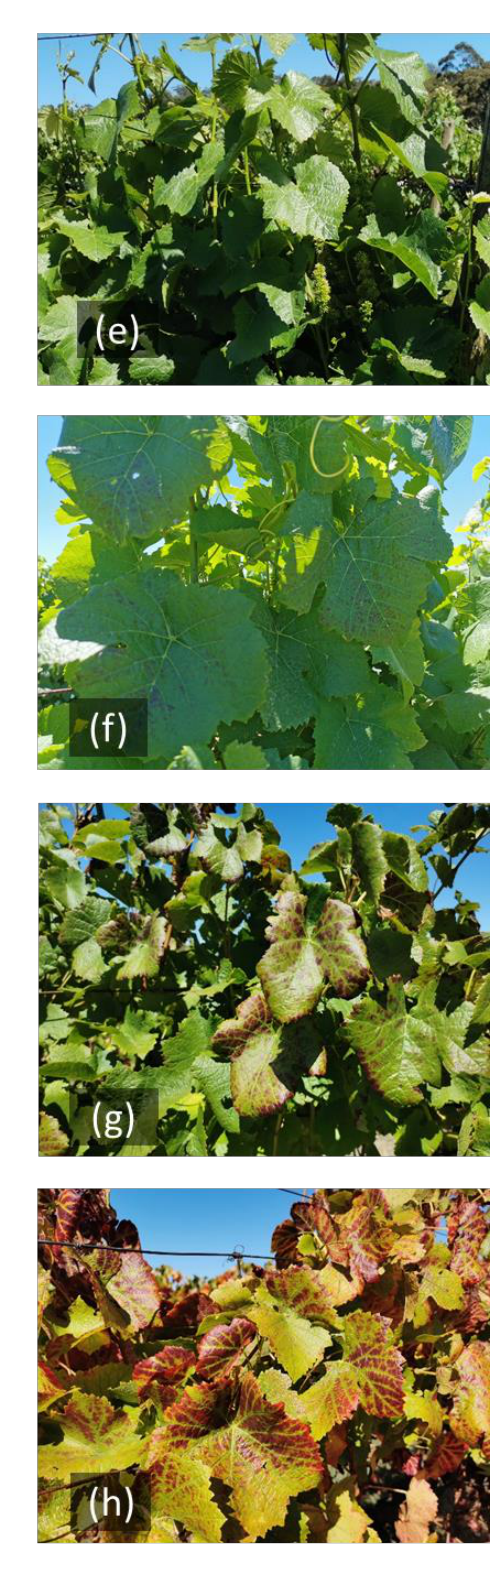
Figure 4. The GLD-infected vines at different development stages. Chardonnay in ( a ) November — flowering stage (EL-17); ( b ) December — pea-size berries; ( c ) February — veraison; ( d ) April — post- harvest. Pinot Noir in ( e ) November — flowering; ( f ) December — pea-size berries; ( g ) February — veraison; ( h ) April — post-harvest.